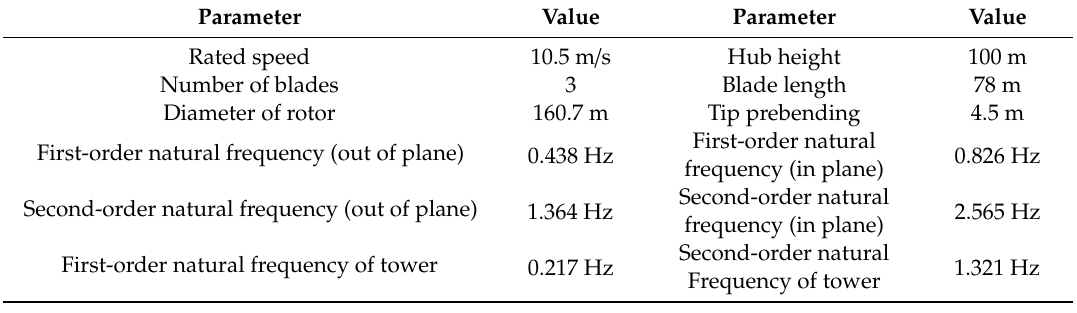
Table 1. 6 MW wind turbine parameters.